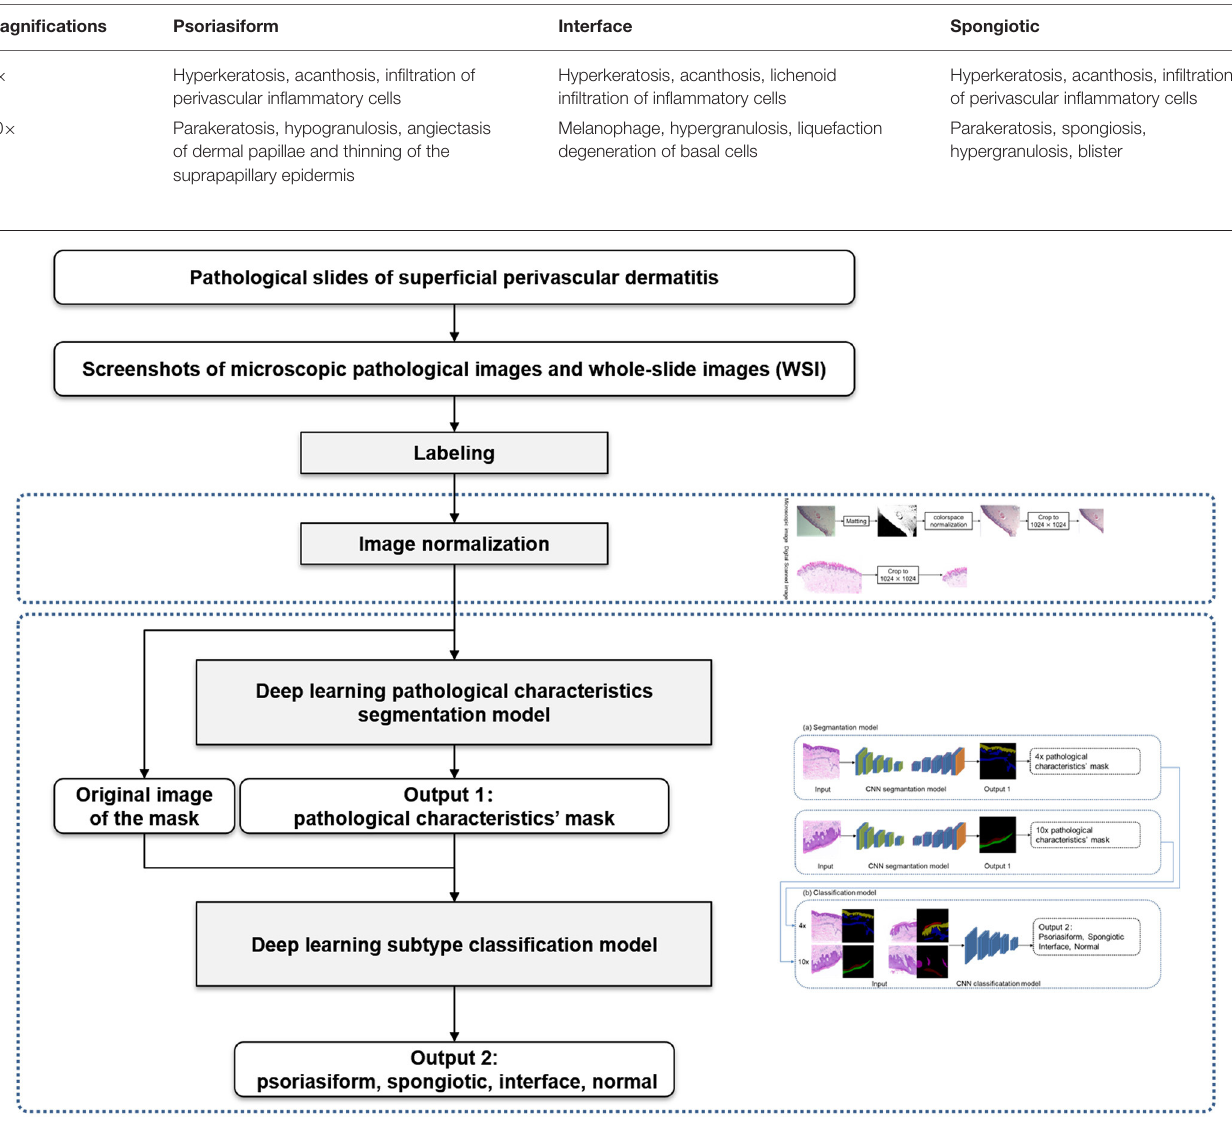
FIGURE 2 | Overall framework of the